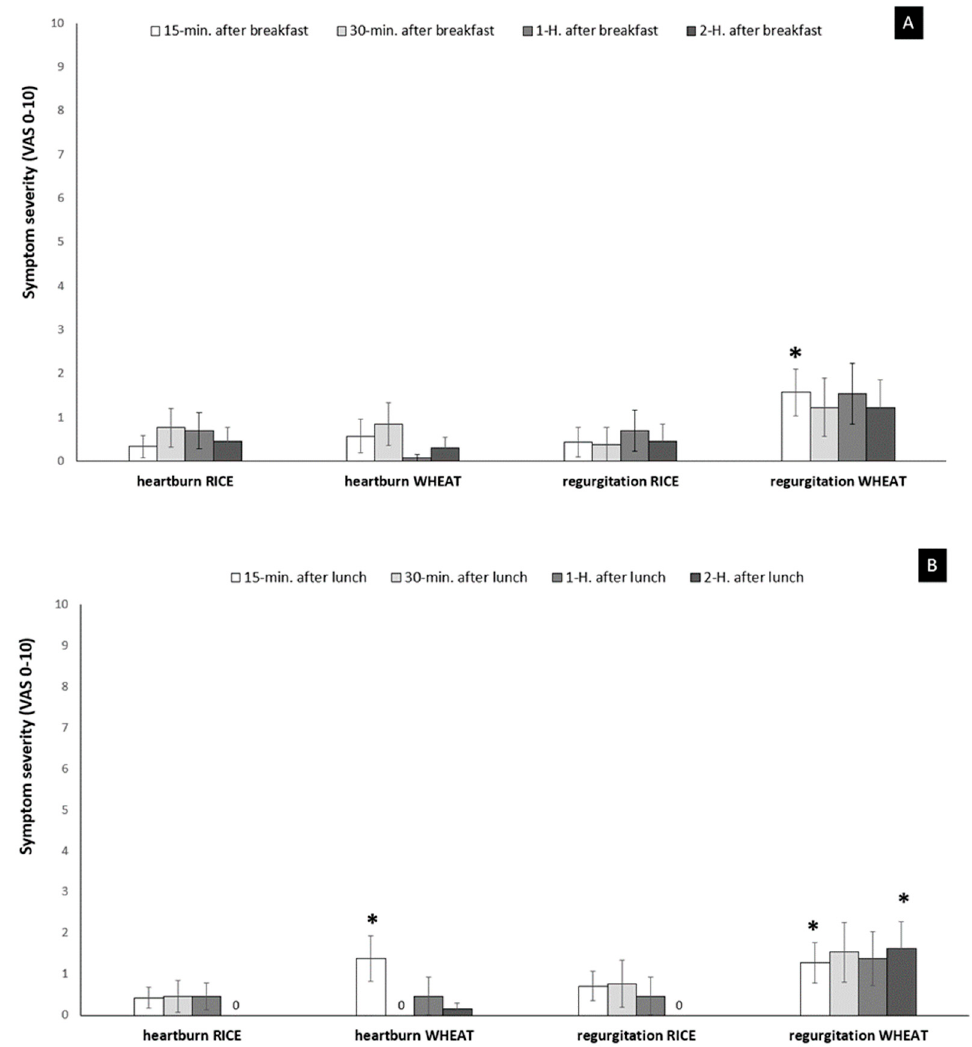
Figure 1. The typical gastroesophageal reflux disease (GERD) symptoms scores at postprandial period comparing between wheat and rice noodles ingestion. ( A ) shows symptoms after breakfast, and ( B ) shows symptoms after lunch. Heartburn and regurgitation were evaluated by visual analog scale (VAS) 0–10. * p < 0.05 wheat noodles vs. rice noodles. Data expressed as mean and SEM.